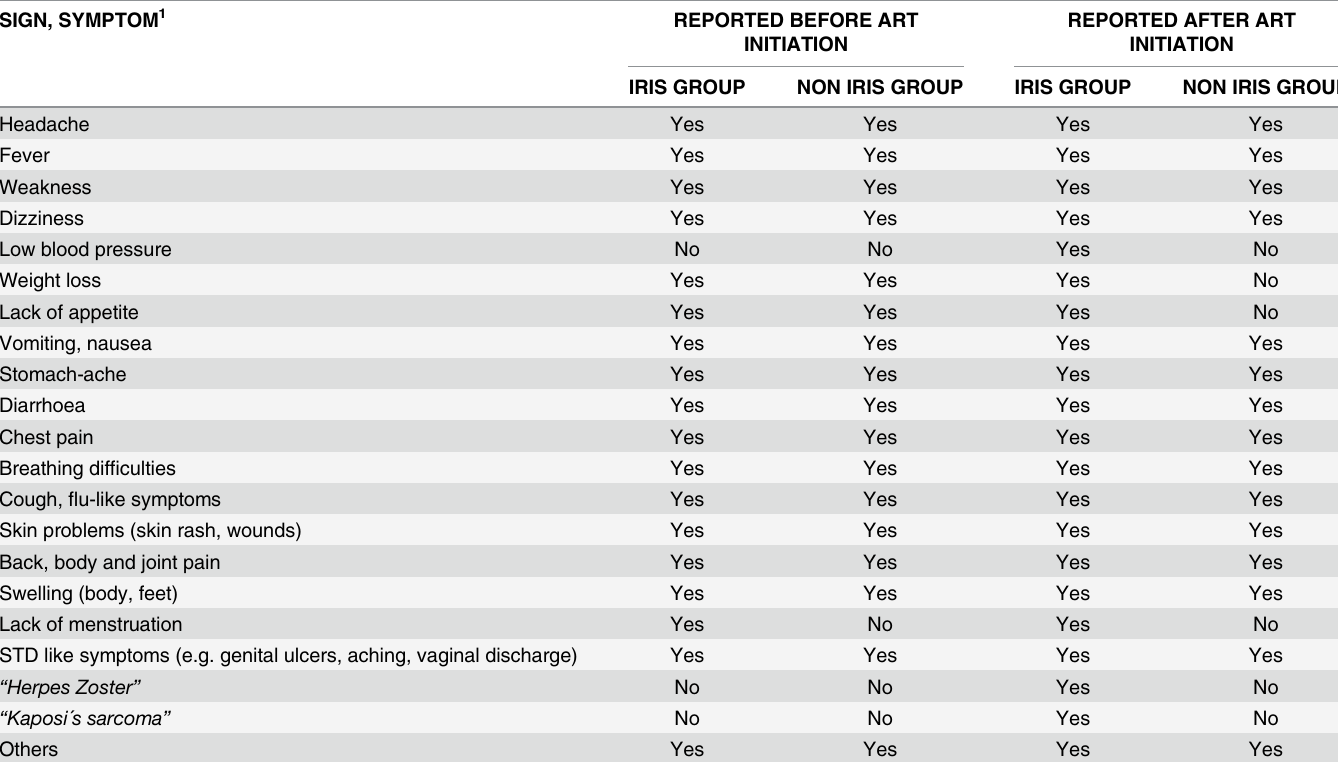
Table 3. Signs and symptoms reported by participants. SIGN, SYMPTOM